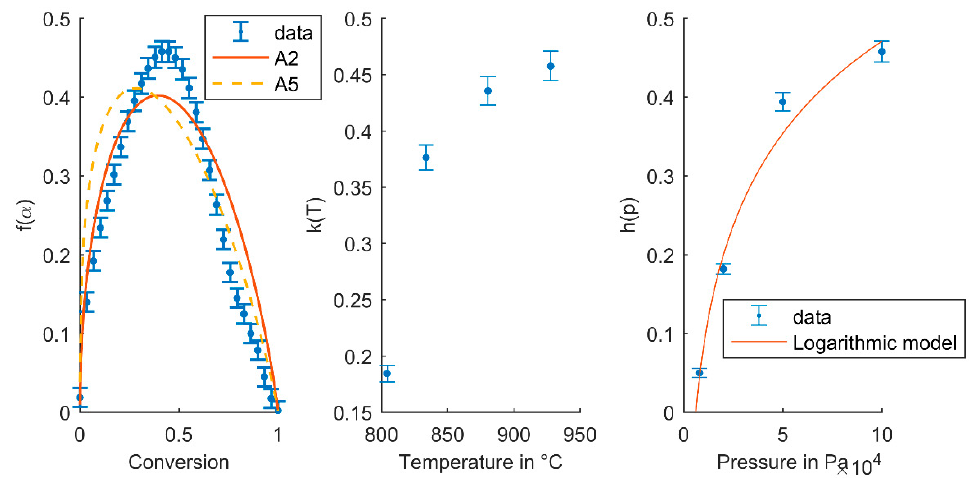
Figure 11. Model generated from all data measured with the NPK method and the best models fitted (A2 and A5) to the experimental data, temperature, and pressure dependences.